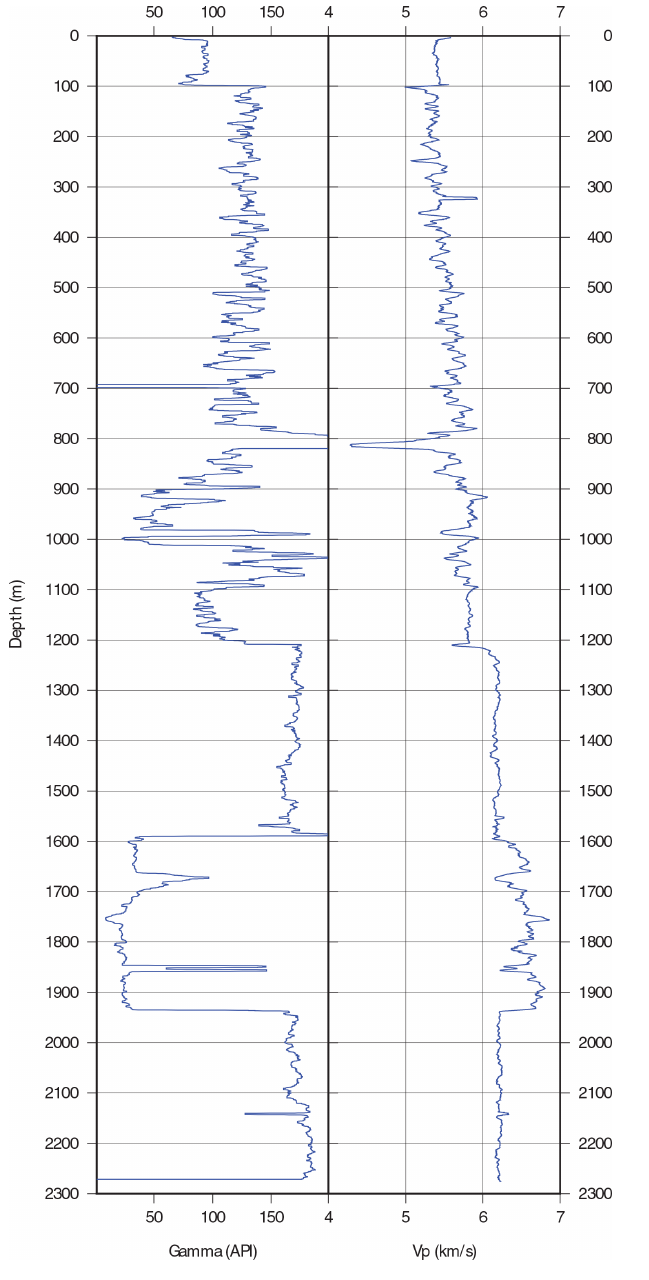
Figure 6. Natural gamma and P-wave sonic logs after smoothing. The sonic log was converted to time to form the basis for the gener- ation of the synthetic seismogram shown in Fig.